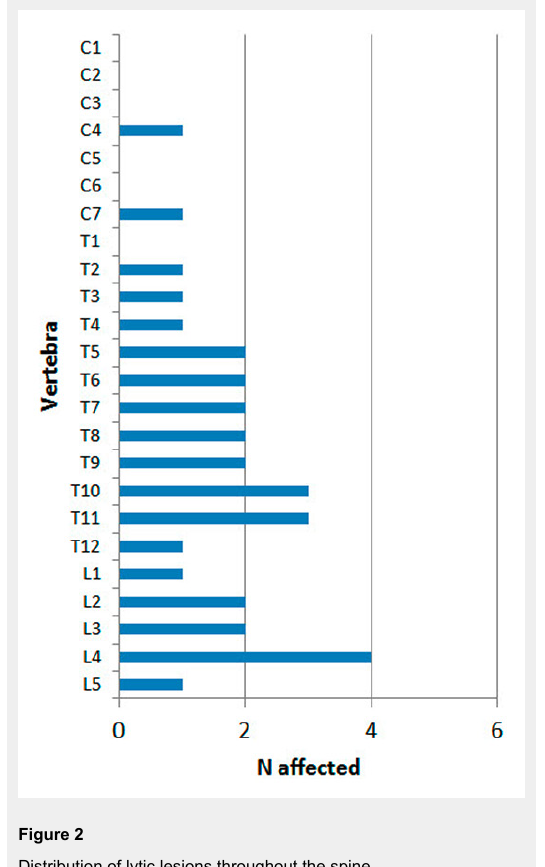
Distribution of lytic lesions throughout the spine.